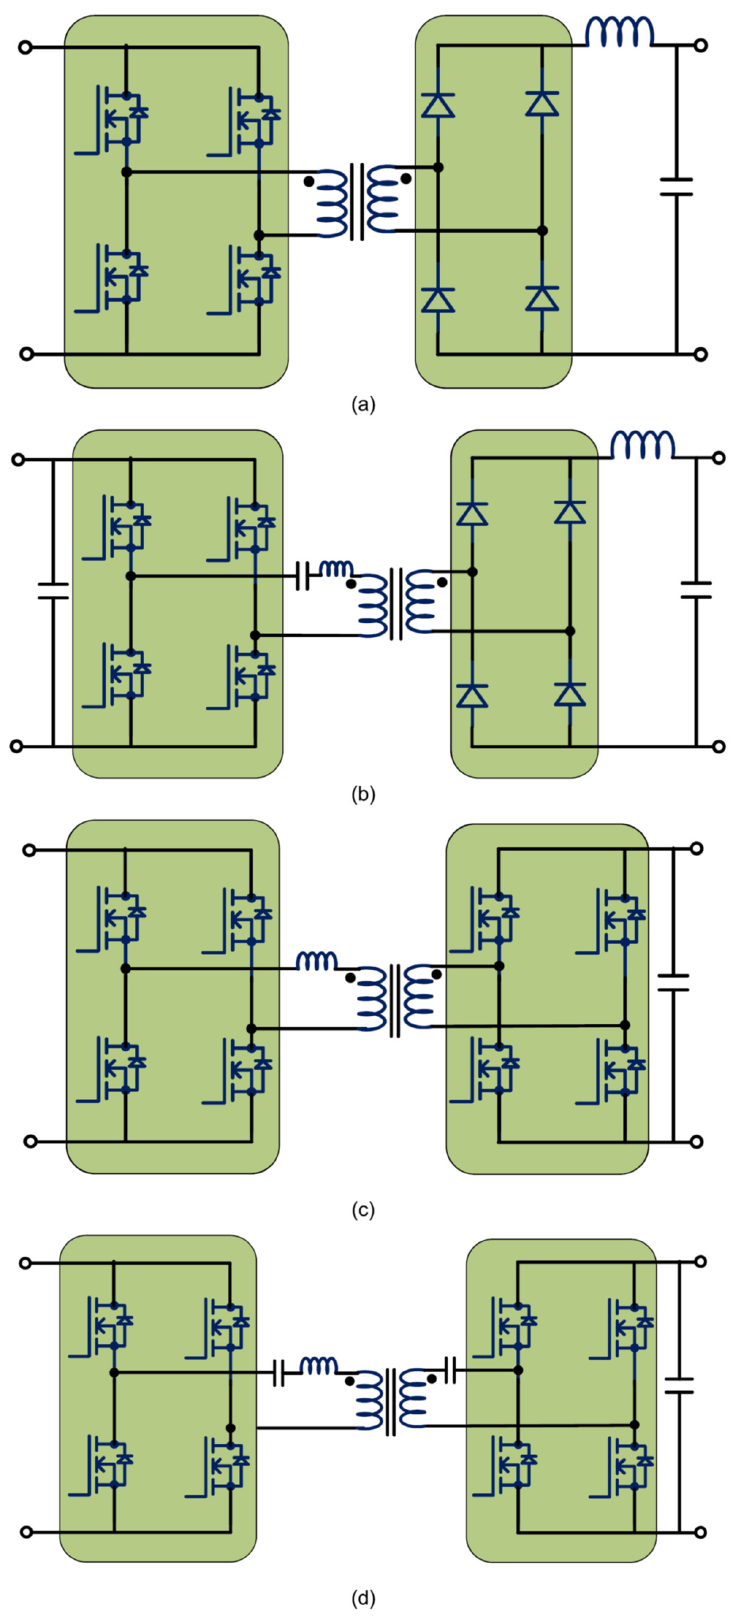
Figure 7. Isolated DC ‐ DC converter topologies for DCFCs: ( a ) PSFB converter; ( b ) LLC converter; ( c ) DAB converter; ( d ) CLLC converter. (Reprinted from Ref. [8].)